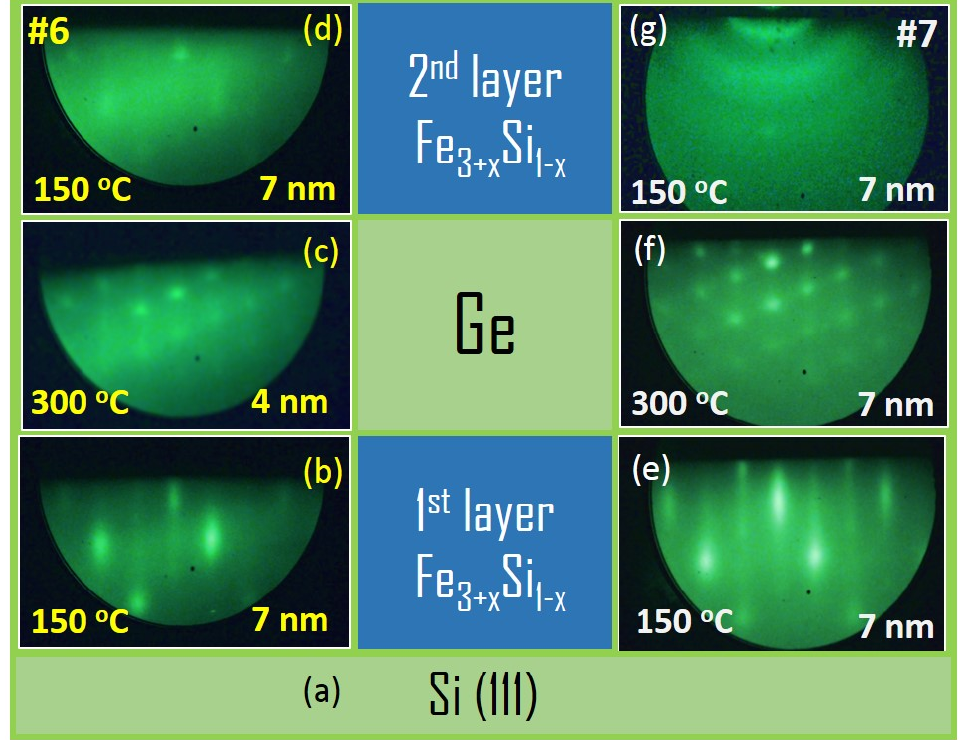
( a ) Middle panel shows the schematics of the three-layer structure Fe 3+ x Si 1 − x / Ge/Fe 3+ x Si 1 − x /Si(111). The panels on the left and right show the respective RHEED patterns obtained after deposition of the respective layer for samples #6 and #7: ( b )—1st Fe 3+ x Si 1 − x , ( c )—Ge 4 nm, ( d )—2nd Fe 3+ x Si 1 − x and ( e )—1st Fe 3+ x Si 1 − x , ( f )—Ge 7 nm, and ( g )—2nd Fe 3+ x Si 1 − x ,